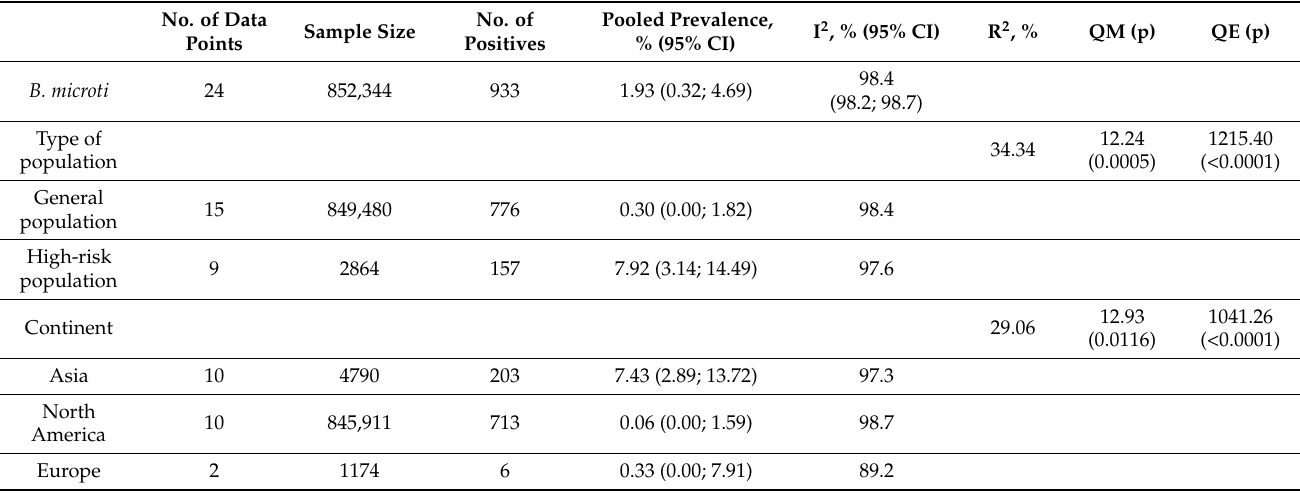
Table 1. Estimates of pooled nucleic acid prevalence and subgroup analysis of zoonotic Babesia in